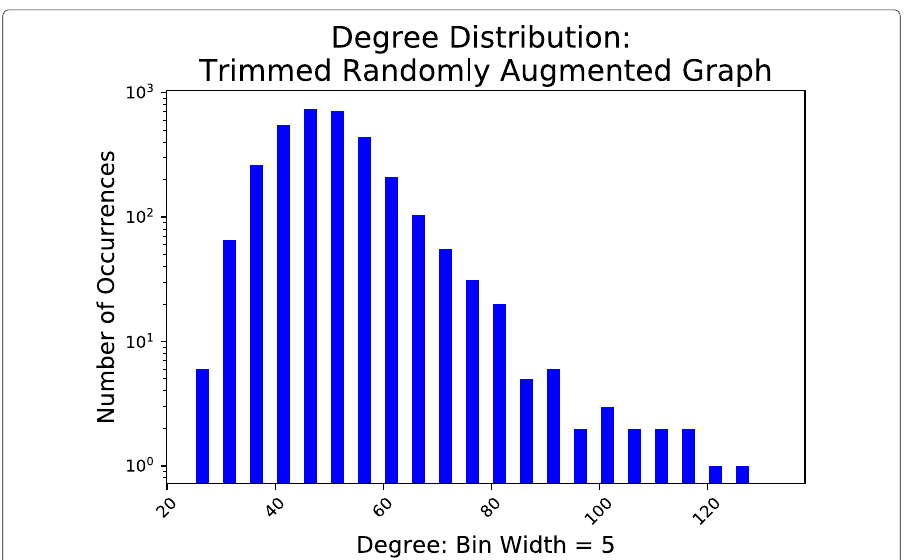
Fig. 8 Degree Distribution — IBM Randomly Augmented Trimmed Graph (log